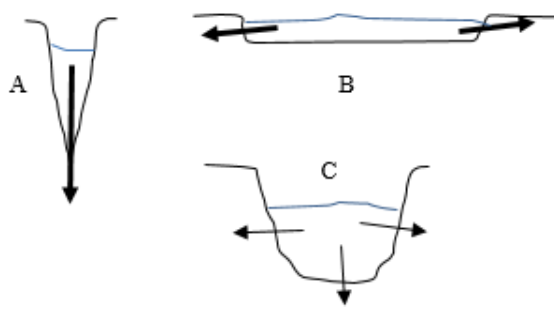
Figure 1. Mutual control of depth and width in a natural flow. First equilibrium (A), second equilibrium (B) and third equilibrium